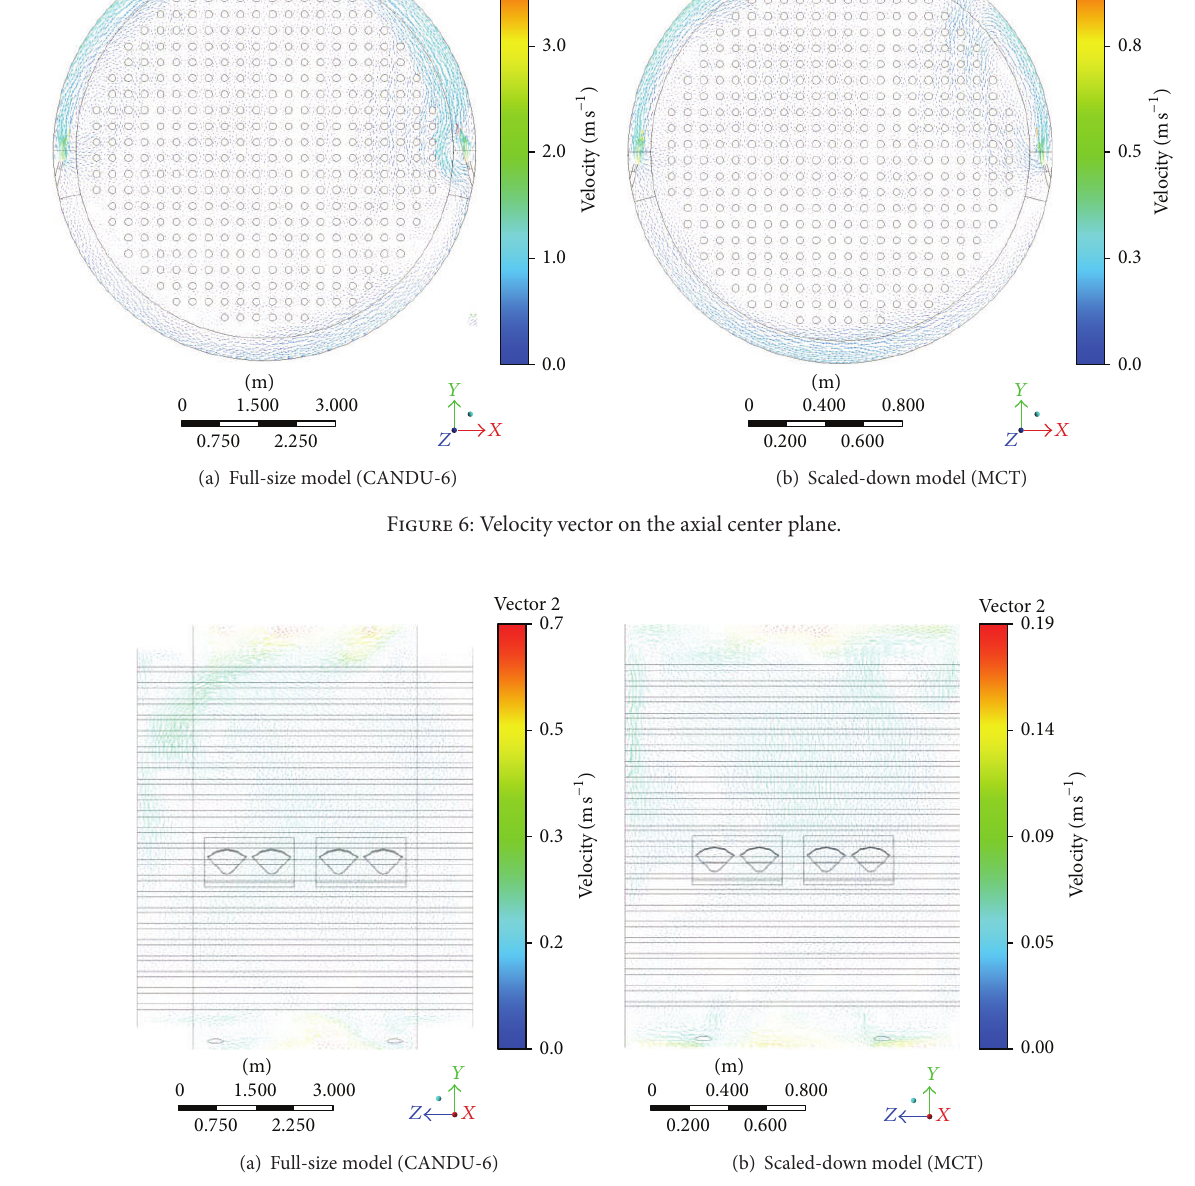
Figure 7: Velocity vector along the axial